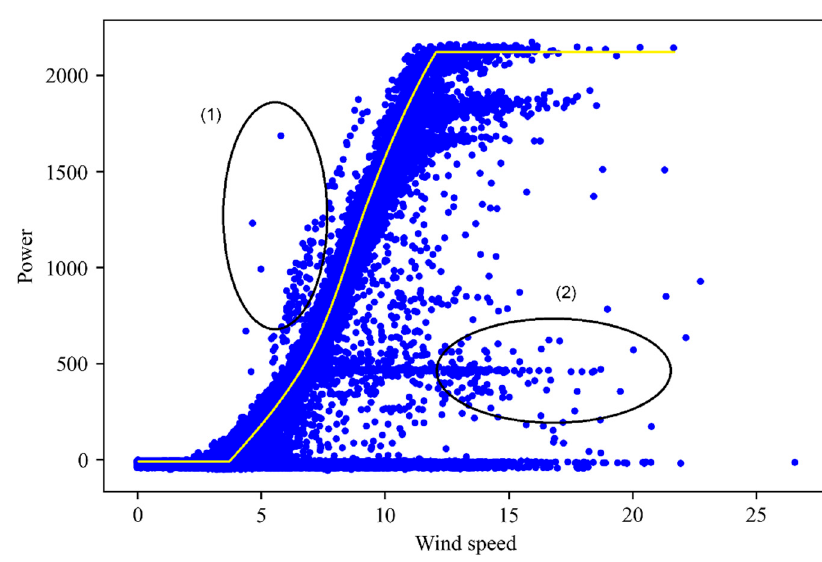
Figure 1. Actual wind speed-power scatter point and ideal wind speed-power curve.